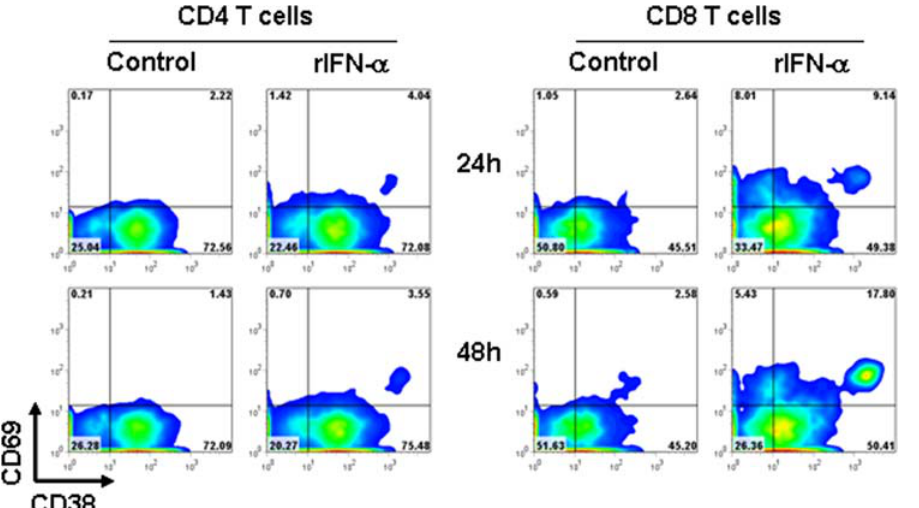
Figure 2. rIFN- a induces increased CD69 and CD38 on T cells. PBMC from HIV-uninfected donors were cultured for 24 (upper panels) and 48 hours (lower panels) in presence or absence of recombinant IFN- a (rIFN- a ). CD38 and CD69 expression were analyzed by flow cytometry on gated CD3 + CD4 + and CD3 + CD8 + cells (CD4 and CD8 T cells, respectively). Flow cytometry contour plots of CD69 and CD38 expression for one example experiment for CD4 (left panels) and CD8 T cells (right panels).